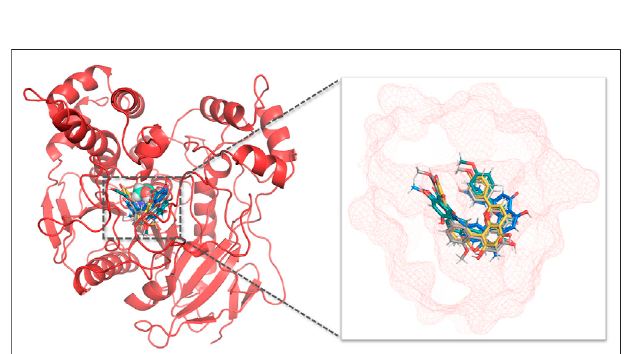
FIGURE 9 | RMSD vs. time plot of bilobetin originated from the two different binding modes toward CES2 by the ensemble docking method. Mode 1 reached an equilibrium state, while mode 2 underwent large fl uctuations.